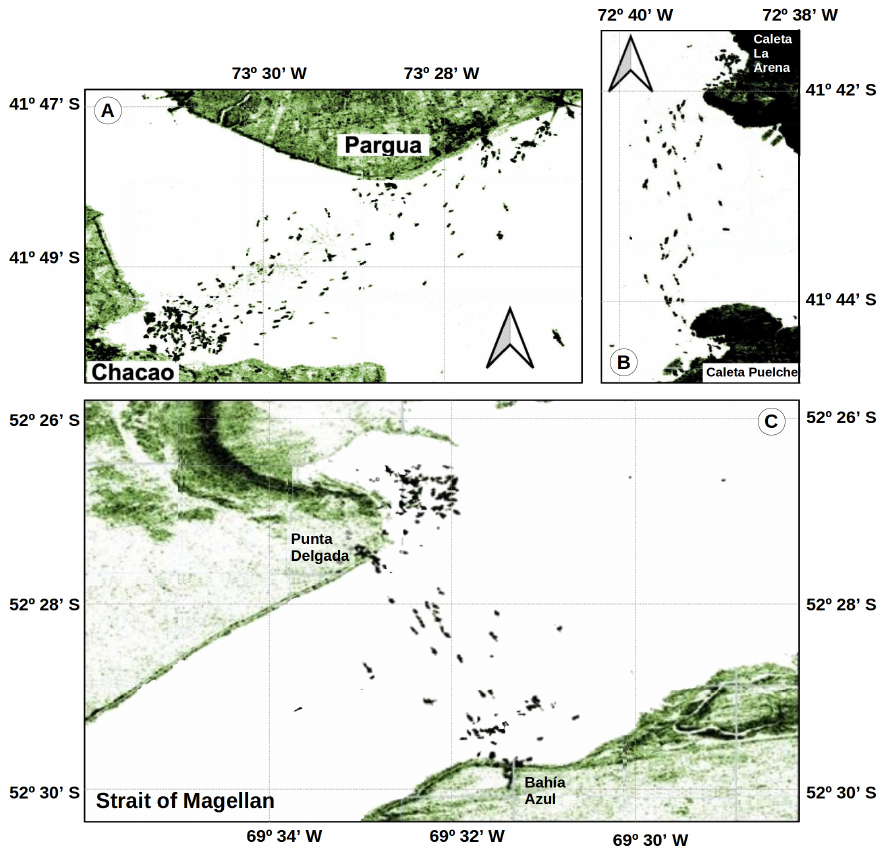
Figure 3. Maps composite of the total number of ships for the entire study period in each area of interest computed in Google Earth Engine (GEE) using detection script for the period April–May 2015–2020. ( A ) Chacao Channel, ( B ) Reloncavi Estuary, ( C ) Strait of Magellan. As of early April 2020, the ship reduction was drastically diminished in the areas of study. The maritime route of the Chacao Channel is the main gateway to Chiloe Island. The ferries run 24 h a day and 7 days a week. The lane crosses from the small town of Pargua (on the mainland) to Chacao (on the island). The results show the complete absence of ship traffic, with dense anchored vessels on both sides of the channel (Figure 3A). In the case of the Reloncavi Estuary, most of the vessels were anchored in Caleta La Arena